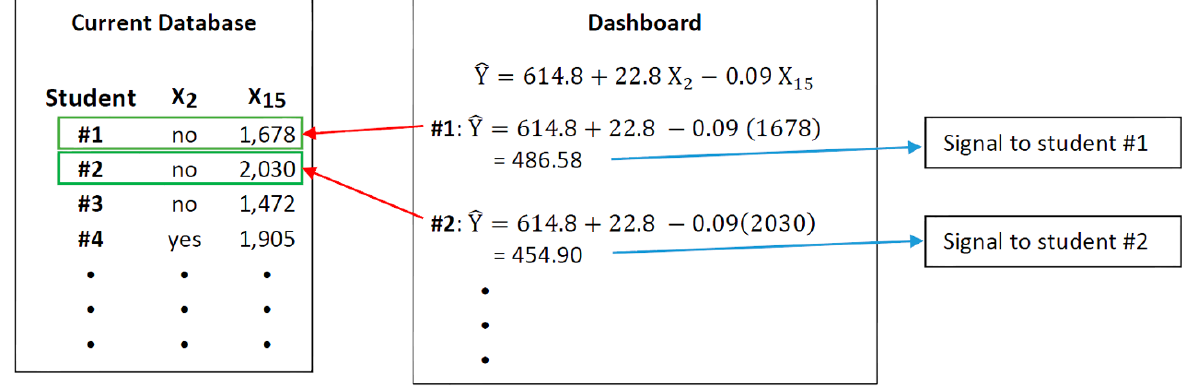
Figure 3. The implementation